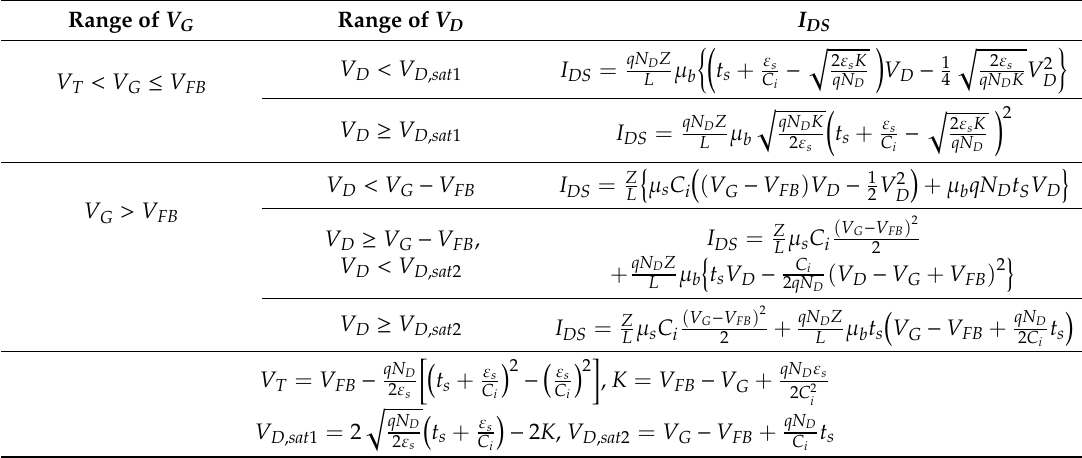
Table 4. Equations for I DS with di ff erent V G and V D